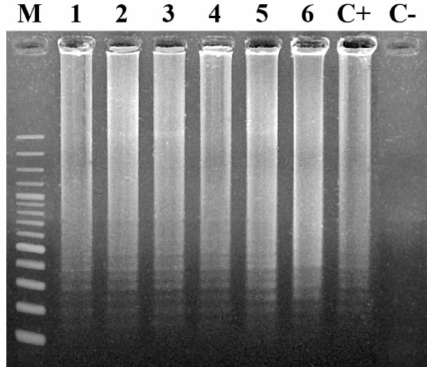
Figure 2. Typical electrophoretic analysis on a 2% agarose gel followed by ethidium bromide (EtBr) staining of LAMP amplified products, using a specific primer set. The LAMP method forms amplified products of various sizes (“ladder pattern”), consisting of alternately inverted repeats of the target sequence on the same strand. Lane M: 1 kb ladder (Nippon Genetics); lanes 2–6: positive LAMP reaction samples; lane C + : positive control; lane C − : negative